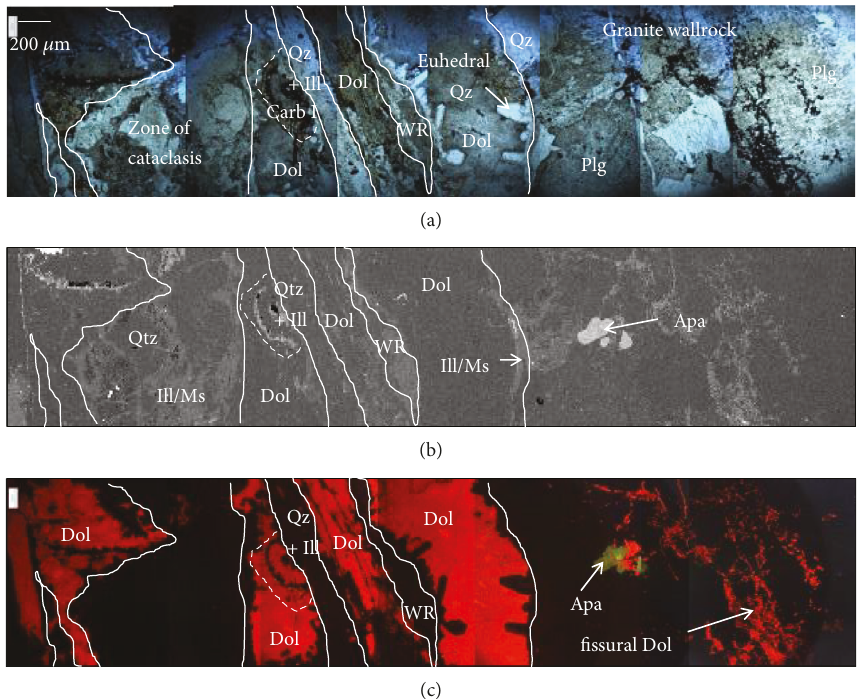
Figure 9: Image in transmitted natural light (a), backscattered electron image (b), and CL image (c) of a NW-SE mm-thick fracture and its granite wall-rock (WR) (EPS1-1427.30 m core sample) (images modi fi ed from [119]). Combined images provide evidence of polyphase fi lling of the fracture including a fi rst stage of cataclasis cemented by quartz (Qz) and illite-muscovite (Ill/Ms) followed by euhedral quartz, then carbonate (dolomite) well identi fi ed by its red-orange color under CL. On the right side of the images, alteration of the wall-rock is marked by partial dissolution of plagioclase (Plg), precipitation of carbonate in secondary porosity in dissolved plagioclase and alteration of primary apatite (Apa) well identi fi ed by CL by yellowish-green